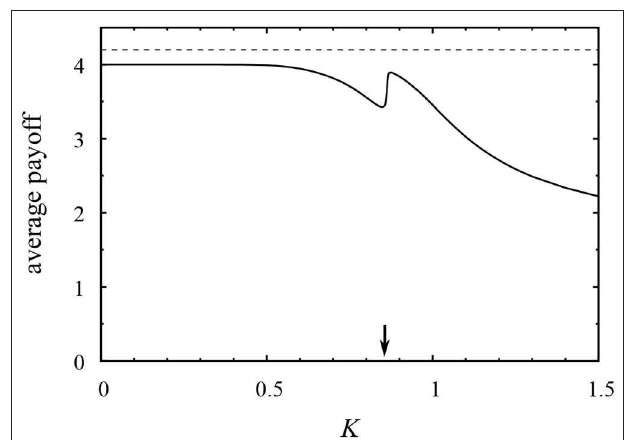
FIGURE 6 | Average payoffs as a function of K for a logit-rule controlled model on a square lattice whose pair interaction is defined by Equation (27) when ε 0.05 and λ 0.1. The dashed line corresponds to the highest possible = = average payoff, which is achieved when all players choose strategy 1. The vertical arrow shows the noise level at which the dominance of strategy 3 turns sharply into the dominance of strategy